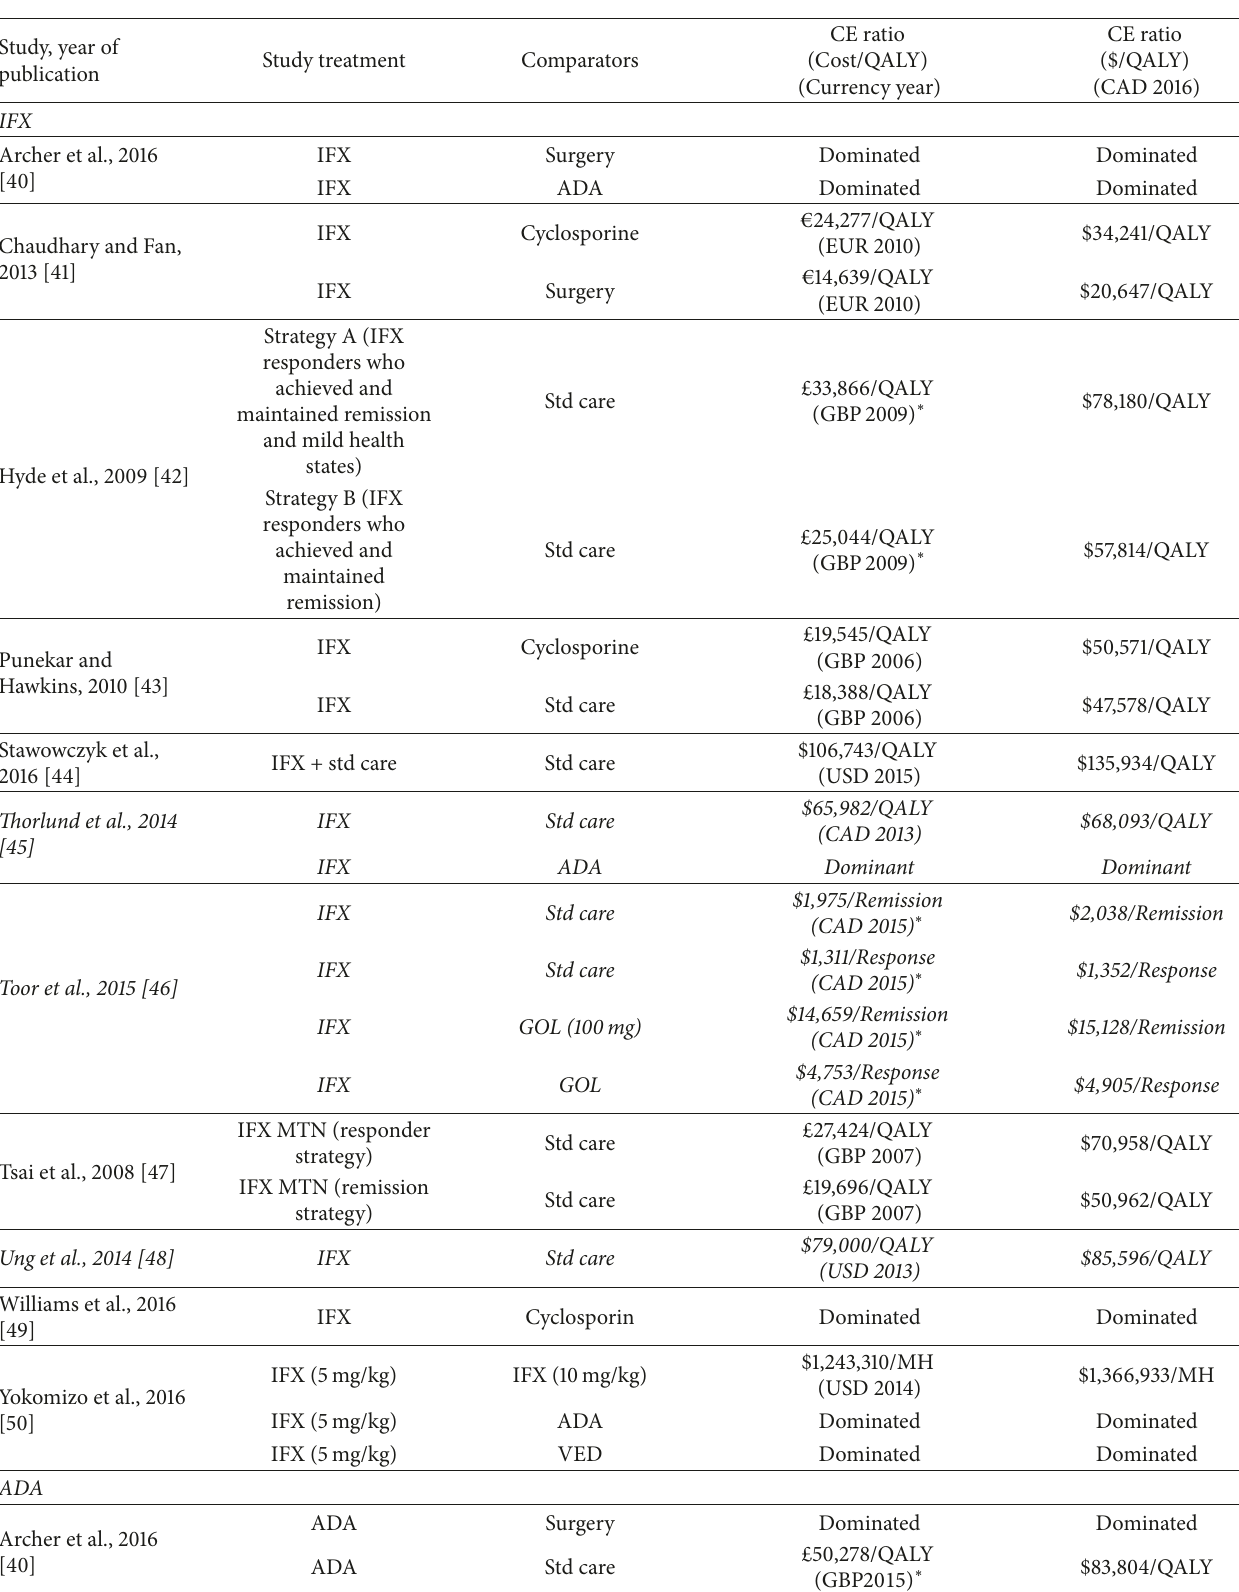
Table 3: Summary of economic evaluations in the treatment of